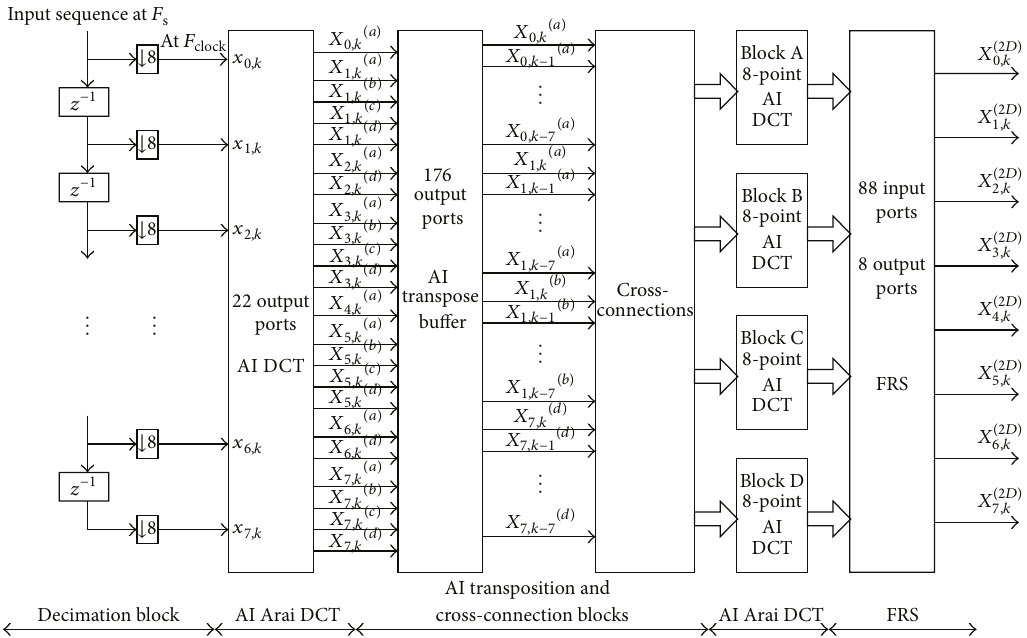
Figure 2: The 2D AI-DCT consists of an input section having a decimation structure, 1D 8-point AI-DCT block for column-wise DCTs, a real-time AI transpose buffer [16], four parallel 1D 8-point AI-DCT blocks for row-wise DCTs, and the FRS [16].